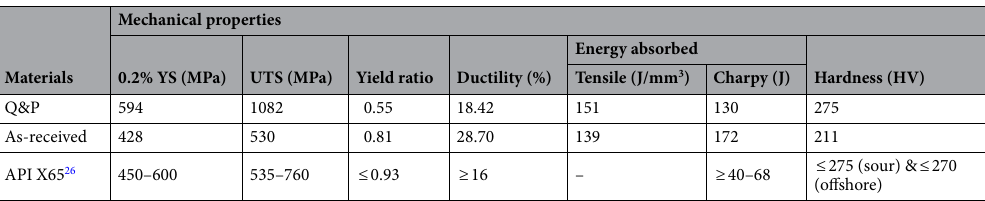
Table 2. Mechanical properties of quenching and partitioning heat-treated microalloyed low carbon